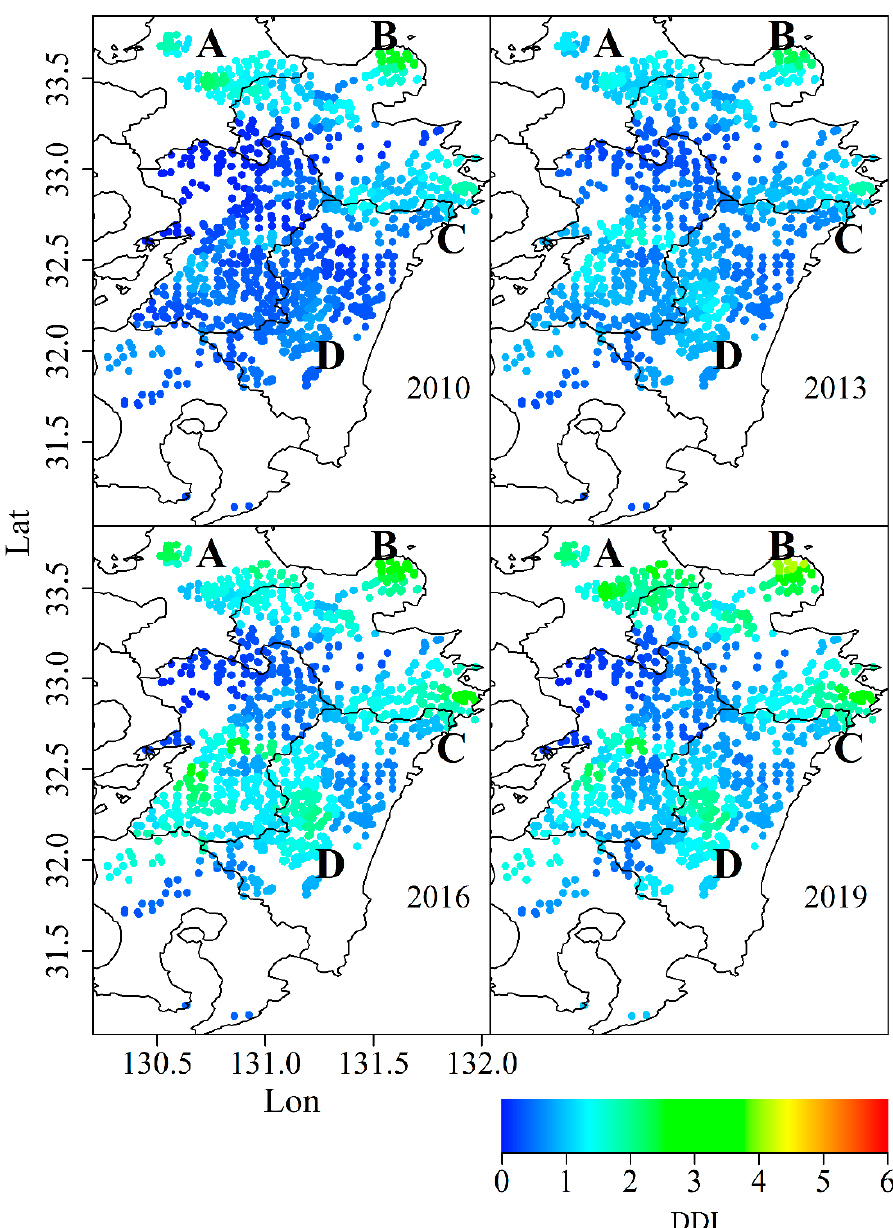
Figure 2. Spatio-temporal changes of deer density at survey sites from 1995 to 2019. A to D indicate the locations of core areas with high deer density.